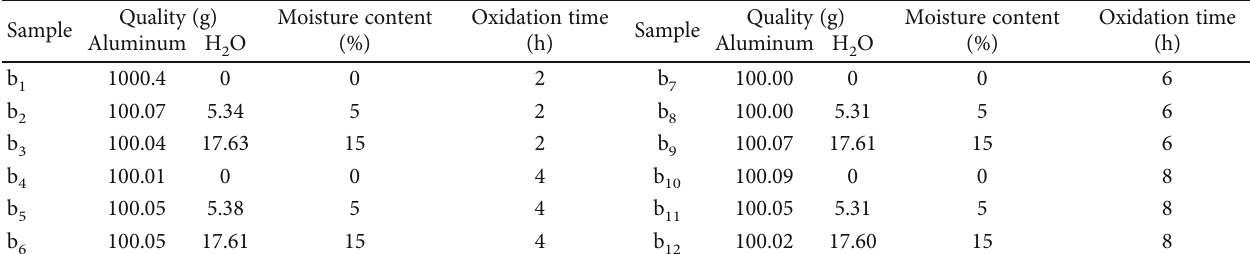
Table 3: Compositions of samples prepared with sample b.